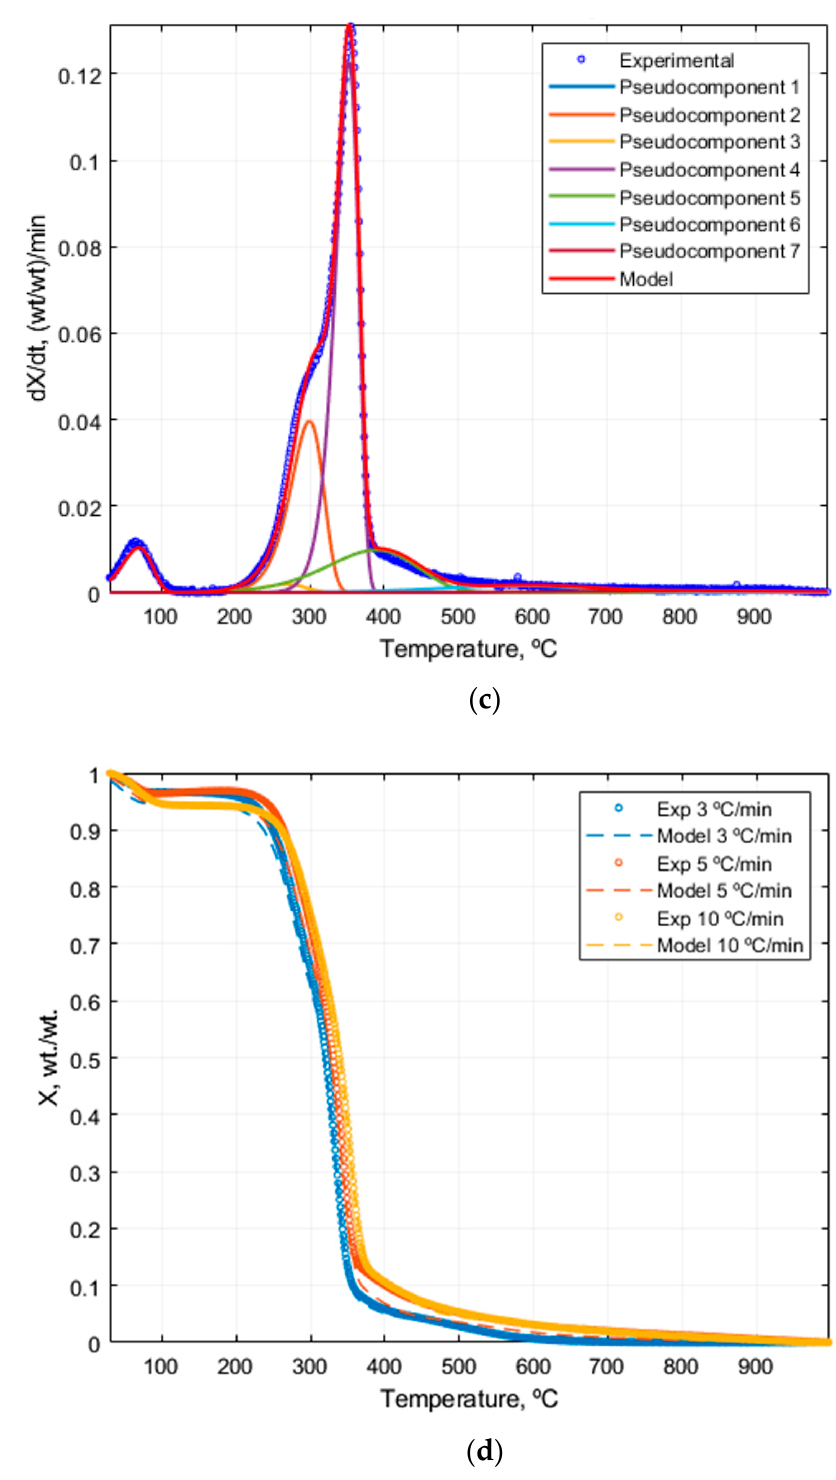
Figure 13. Model fitted to the experimental poplar DTG and TG curves: ( a ) DTG at 3 ◦ C min − 1, ( b ) 5 ◦ C min − 1 and ( c ) 10 ◦ C min − 1. ( d ) TG at the three heating rates. Table 11 shows the kinetic parameters by fitting the model using a single heating rate and three heating rates simultaneously. The obtained results by both datasets are very similar. For example, the activation energy obtained is identical for almost all the pseudocomponents, and only pseudocomponents 3 and 7 have a relative standard deviation of